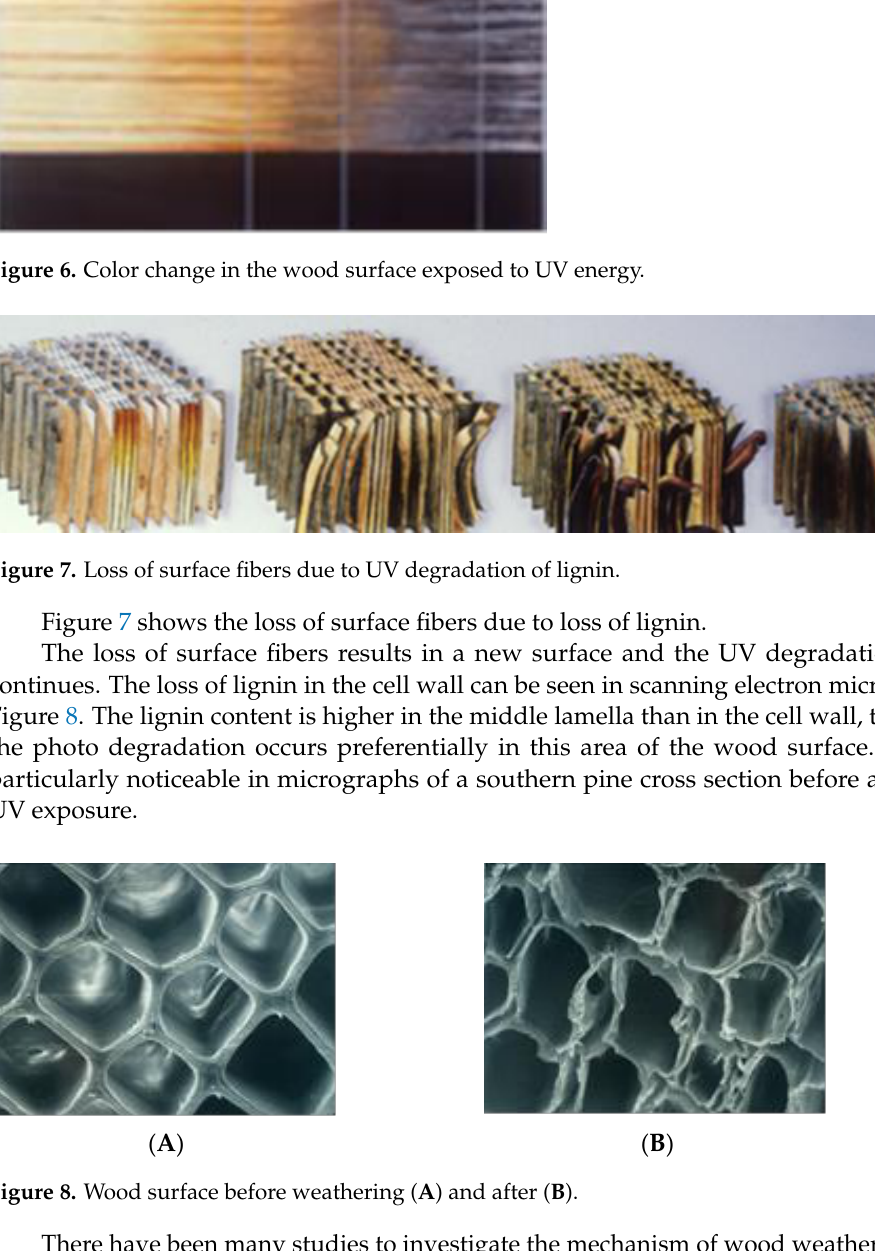
Figure 8. Wood surface before weathering ( A ) and after ( B ).